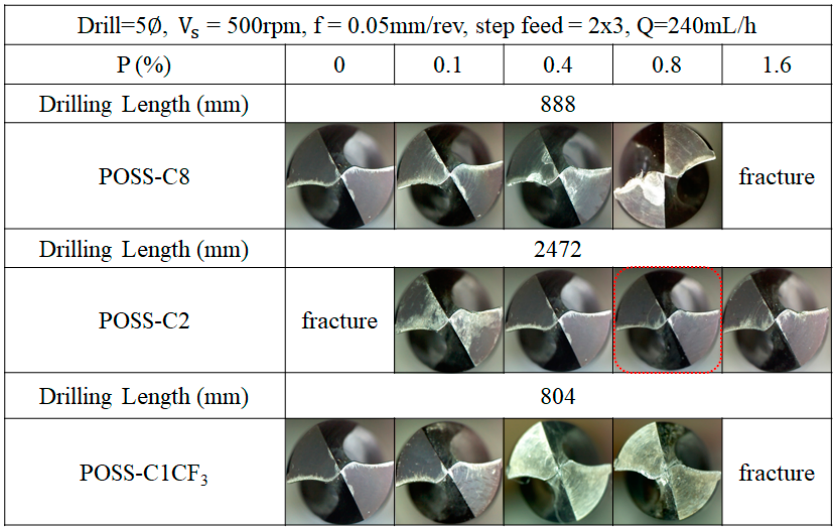
Figure 8. Relationship between L f and POSS concentration in the cutting oil.